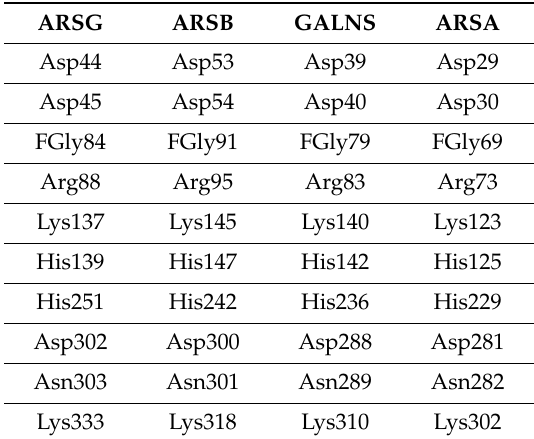
Table 3. Amino acid residues are located in almost the same position in ARSG, ARSB, arylsulfatase A (ARSA), and galactosamine-6-sulfatase (GALNS) and are expected to play equivalent roles in catalysis.